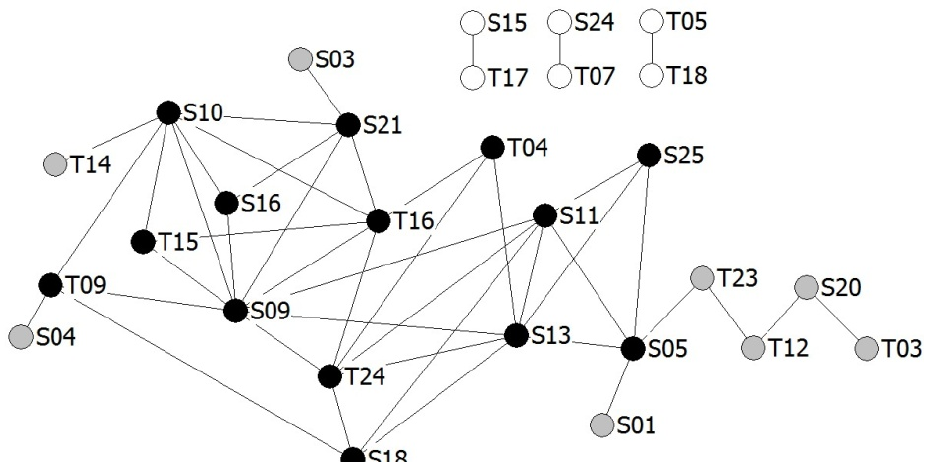
Figure 4. Cluster analysis of respondents to identify